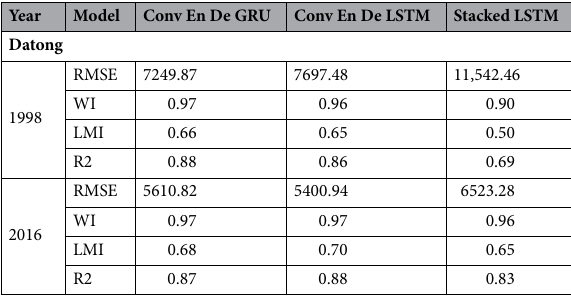
Table 4. Comparison of criteria with different models in Datong station.